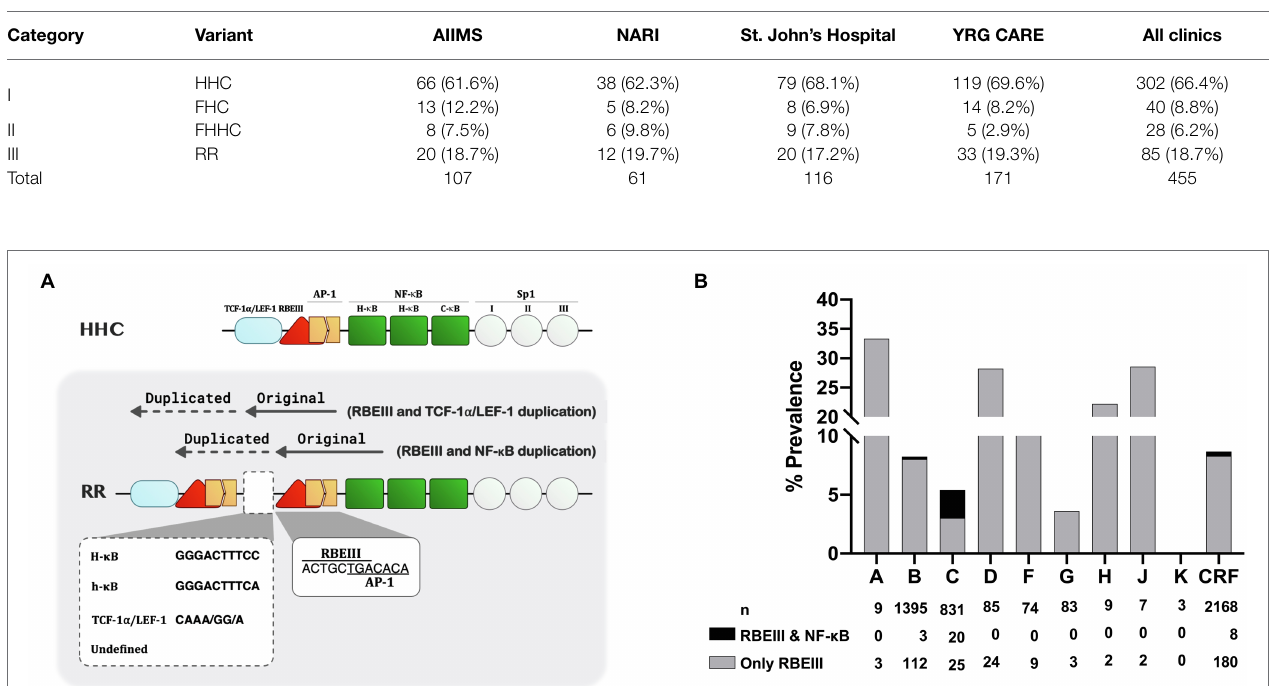
TABLE 1 | Proportion of promoter variants at each clinical site.